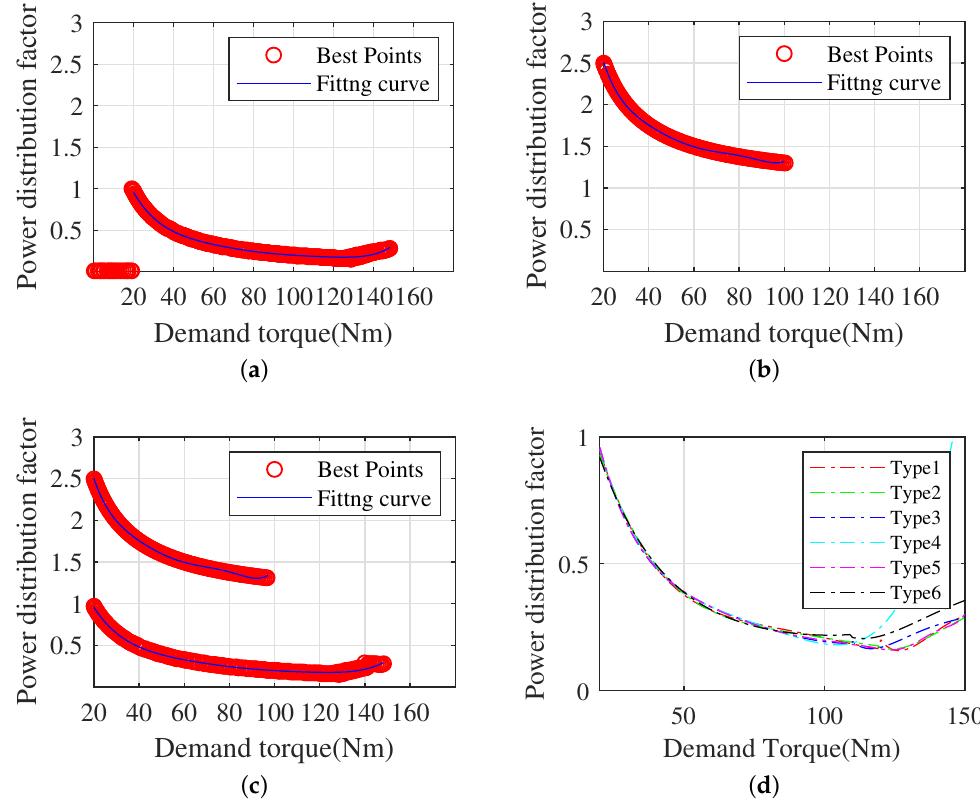
Figure 12. The results of different SOC. ( a ) SOC = 0.8; ( b ) SOC = 0.4; ( c ) SOC = 0.3; ( d ) fitting curves under different type of driving